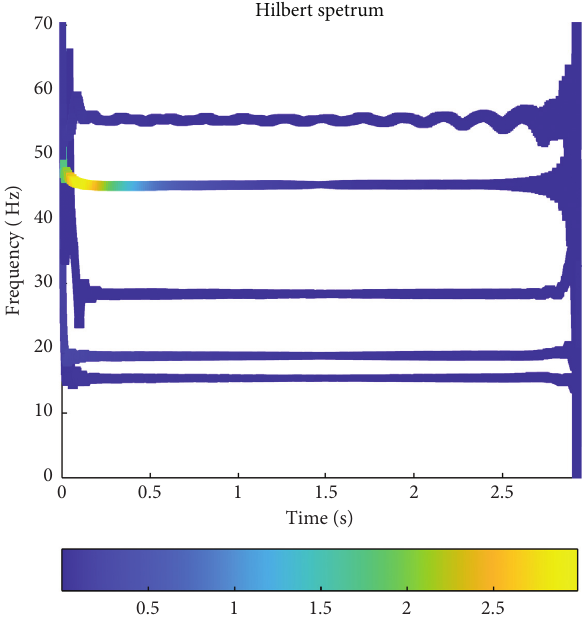
Figure 18: Hilbert spectrum of the extracted five modes.